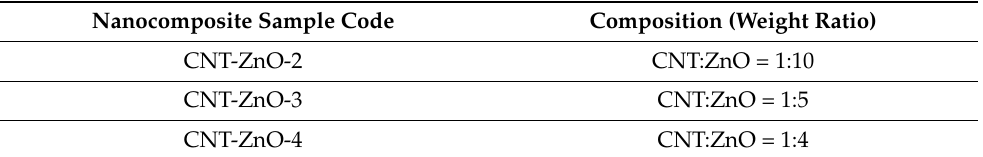
Table 2. Representative ZnO-CNT nanocomposite powders prepared by hydrothermal